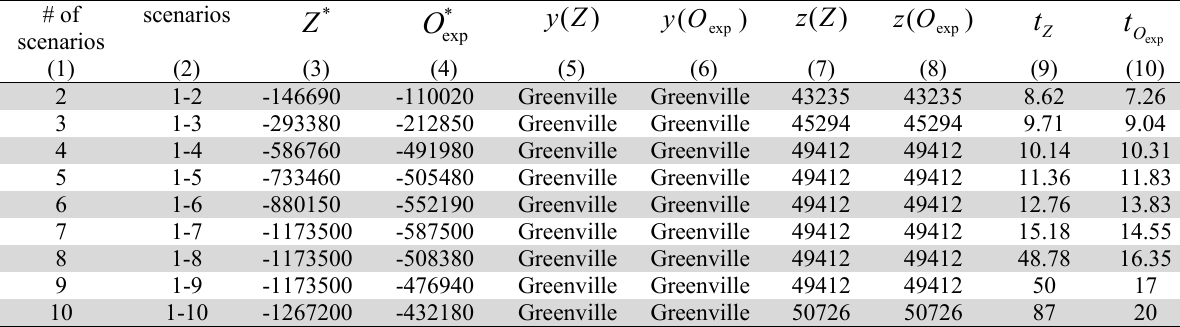
Solutions of the robust models: Z for P1 and O for